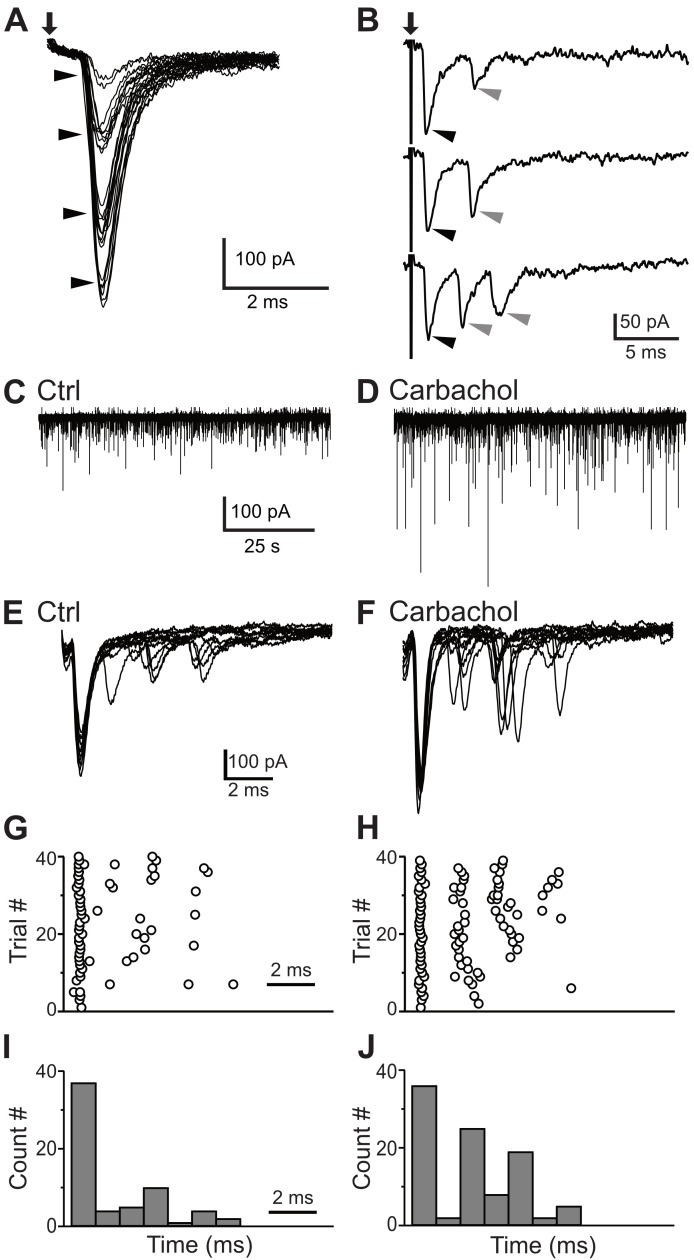
Synaptic inputs to the small glycinergic cells.(A) Stimulation of AN root evoked EPSCs with graded amplitudes. The EPSCs amplitude increased with stronger stimulus strength (arrowheads). (B) Representative example of disynaptic EPSCs with longer latency in response to AN root stimulation (gray arrowheads). (C) Example trace showing sEPSCs measured in small cells under control condition (C) and carbachol (D). The increased in sEPSCs frequency confirms T-stellate cells as disynaptic source of EPSCs. (E) Representative example of eEPSCs in response to AN root stimulation under control conditions (E), raster (G) and PSTH (I) of cell in E. (F–H) Carbachol application significantly increased the number of delayed EPSCs (short latency events < 1 ms, percentage increase = 17.57 ± 0.11%; longer latency events, percentage increase = 92.00 ± 0.13%).